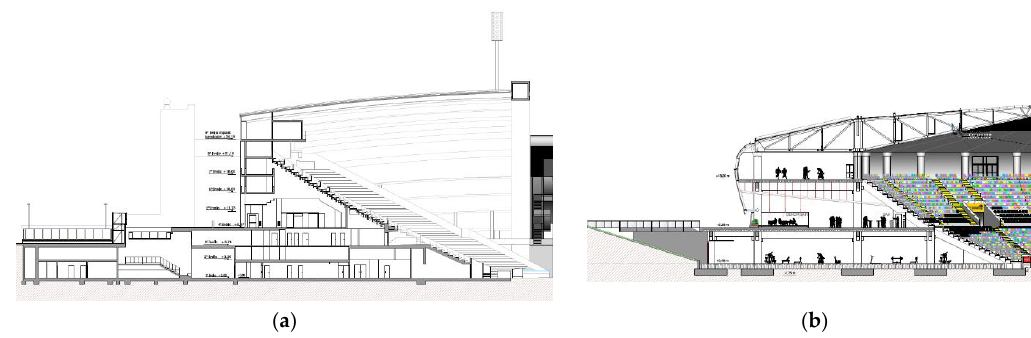
Table 2. List of the main stadium plans which have already been discussed by the local municipalities or which are under discussion at the moment [50,51].